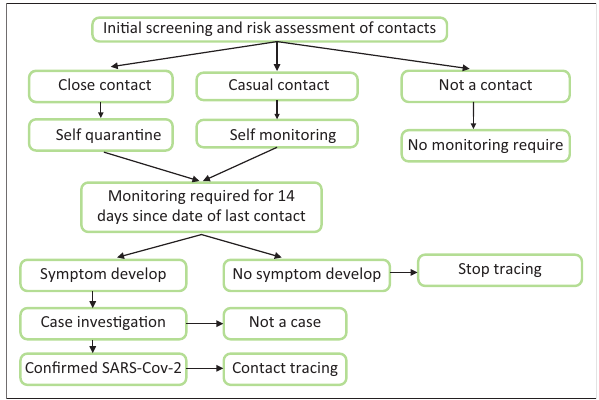
FIGURE 3: Flow diagram for contact tracing, screening and monitoring of coronavirus disease